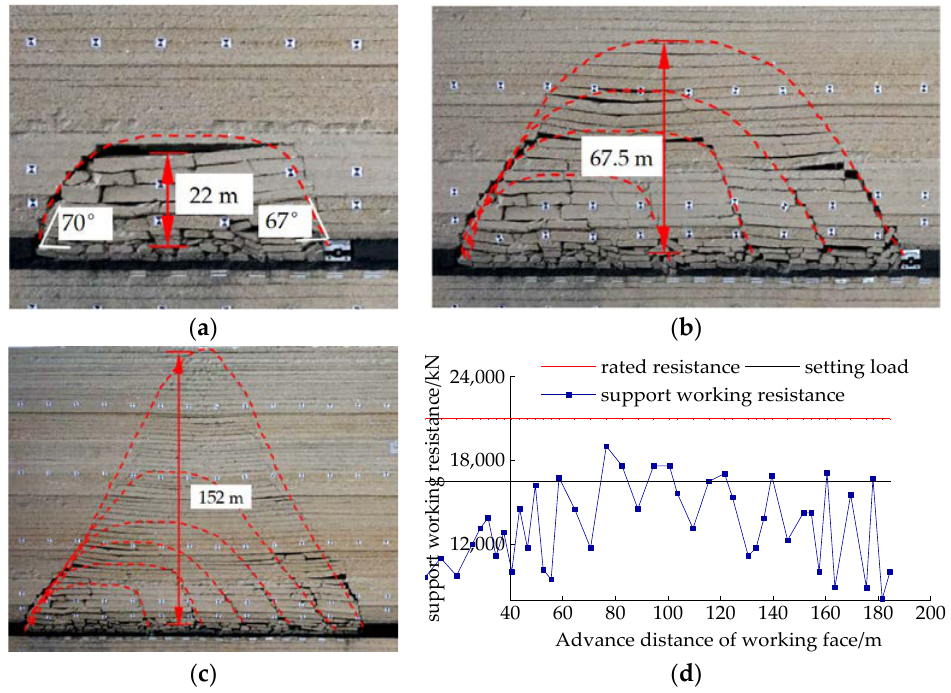
Figure 5. Law of roof caving during periodic weighting: ( a ) FPW1. ( b ) FPW4. ( c ) SPW6. ( d ) Law of the WR during the period weighting.